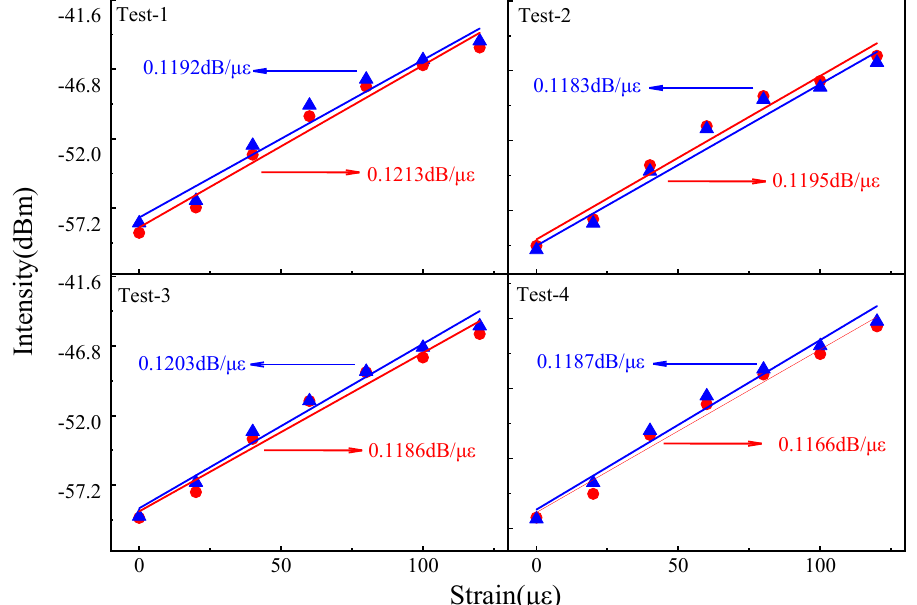
Figure 7. The relationships between intensity variation and increased/decreased axial strain. Further, the sensor head with L TCF = 15 mm is placed into a temperature chamber (LICHEN, 202-00T, Shanghai, China, with a resolution of ± 0.1 ◦ C) to characterize the temperature response. As shown in Figure 8a, the transmission spectrum is red-shifted with the rise of temperature and the intensity of dip is increased by about 1.88 dB. From Figure 8b, the wavelength sensitivity is 0.0736 nm/ ◦ C with the linearity of ~0.99. The corresponding intensity sensitivity is merely 0.0381 dB/ ◦ C in the range from 25 ◦ C to 75 ◦